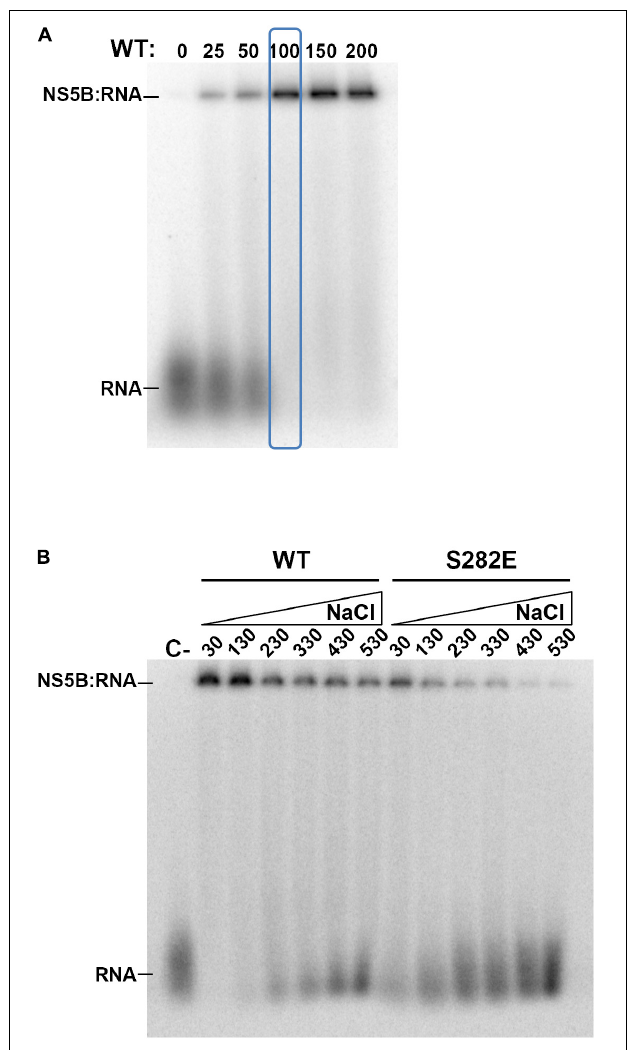
FIGURE 6 | Electromobility shift assays. (A) Gel showing retardation of a labeled RNA (10,000 cpm each lane) by increasing concentrations of WT NS5B. Concentration of WT NS5B is indicated at the top (nM). The protein concentration chosen for the following experiments is indicated by a blue box. (B) Gel showing retardation of a labeled RNA by WT and S282E NS5B proteins at increasing concentrations (30, 130, 230, 330, 430, and 530 mM) of NaCl. Free labeled probe (RNA) and retarded products (NS5B:RNA) are indicated.